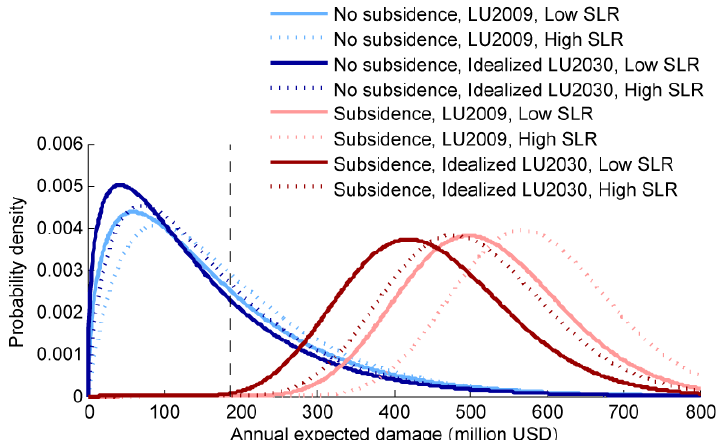
Figure 9. Probability distribution function (PDFs) of future flood risk in Jakarta under different scenarios. The black vertical dashed line shows risk associated with baseline conditions (USD186 million p.a.). The PDFs are obtained by applying a two-parameter gamma distribu- tion to simulated risk values from five GCMs and four RCP emission scenarios. PDFs are shown for different combinations of the following scenarios: (a) subsidence and no subsidence; (b) land use under baseline conditions (LU2009) and under the idealized land scenario for 2030 (LU2030); and (c) high or low sea level rise (SLR). Table 7. Flood risk (annual expected damage) in 2030 for different risk drivers, and percentage change in risk compared to baseline condi- tions. ∗ Using idealized land use scenario for 2030. Scenarios Flood risk (million USD) Percent change Baseline 186 NA Baseline + change of precipitation 101